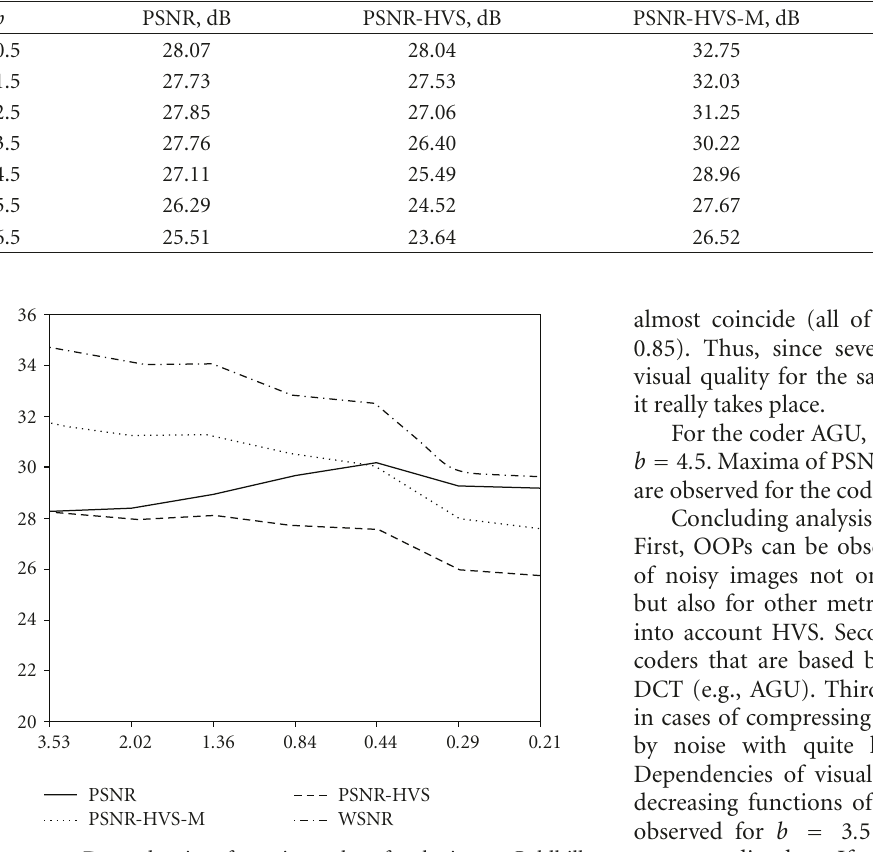
Figure 5: Dependencies of metrics on bpp for the image Goldhill, σ 2 = 100, for the coder